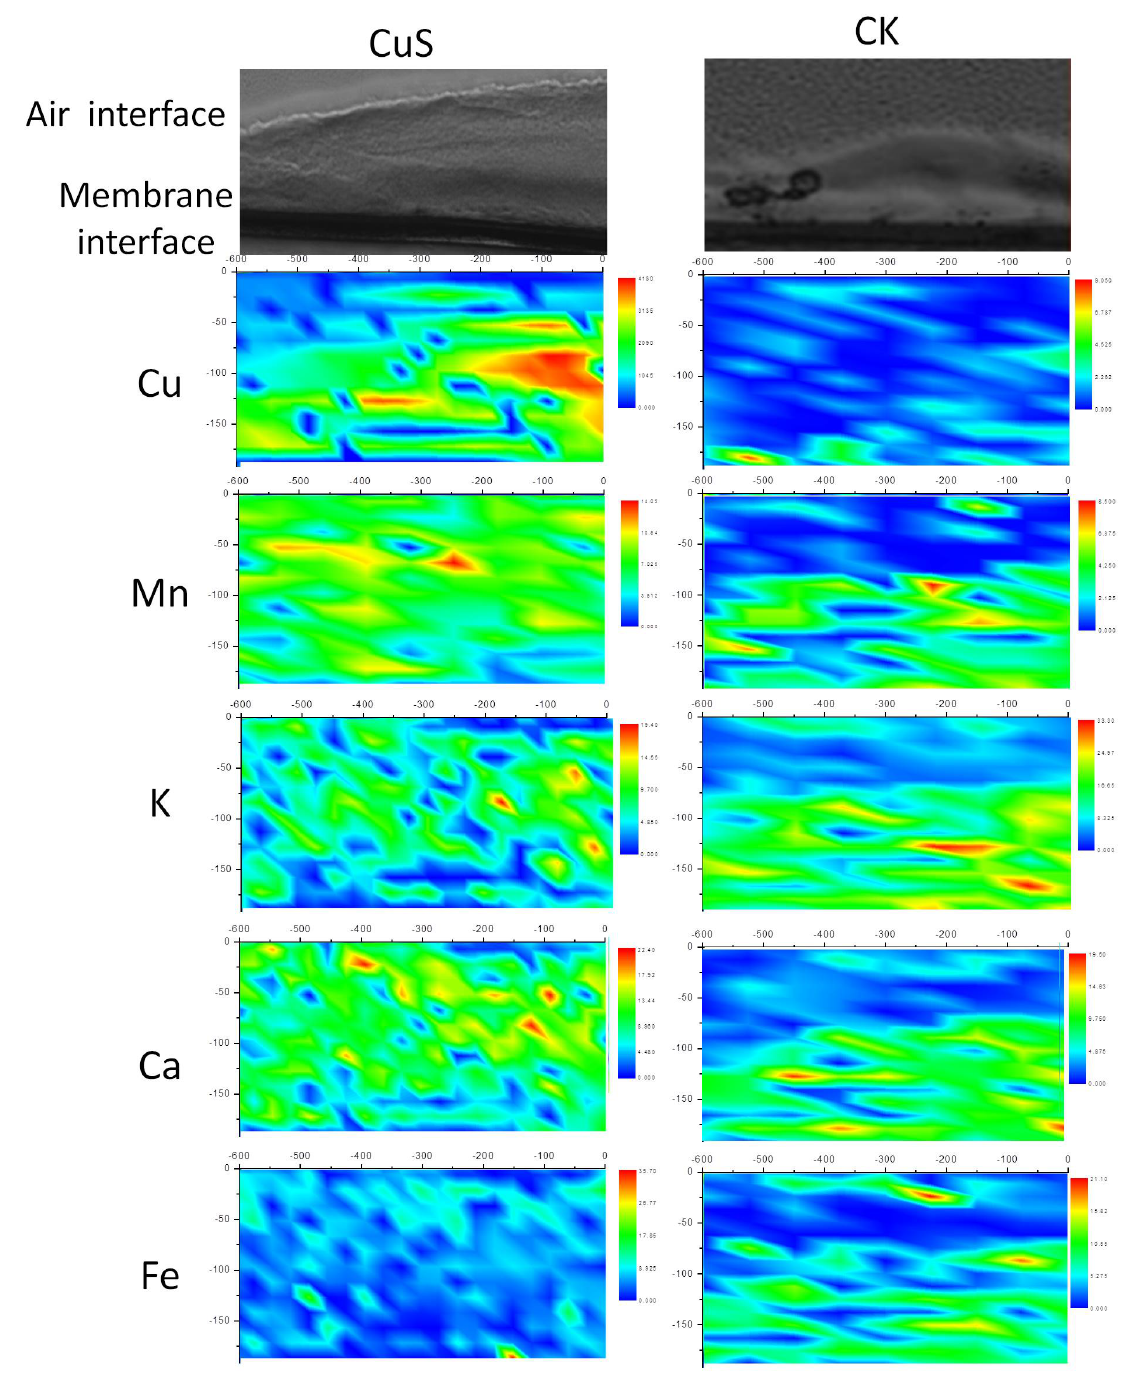
Figure 2. X-ray fluorescence microscopy (XRF) maps of qualitative spatial distributions and concentration gradients of elements in the sections of Halothiobacillus HT1 biofilms grown on LB medium. ( Left ) Halothiobacillus HT1 biofilm reacted with